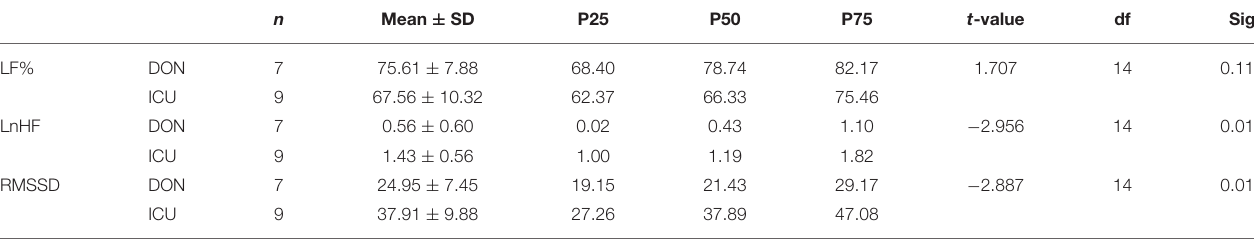
TABLE 2 | The mean differences and standard deviations of HRV parameters.